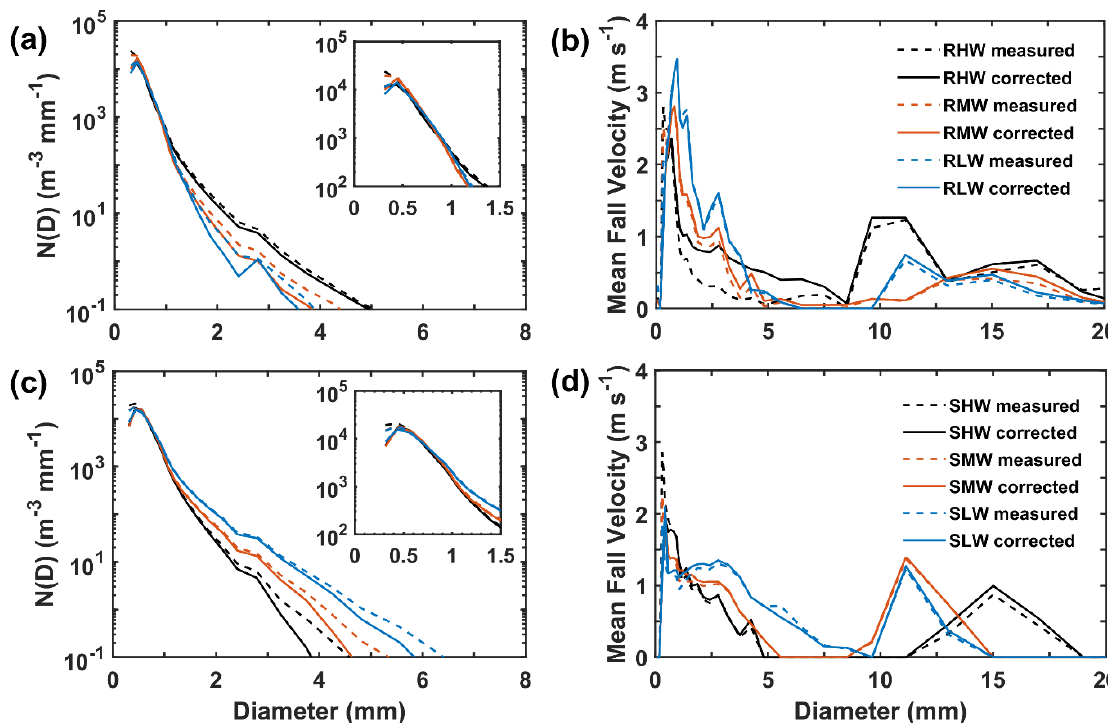
Figure 6. Mean raindrop size spectra for liquid and solid precipitation groups ( a , c ) and mean particle fall speed as a function of particle diameter ( b , d ). The dashed line refers to measured DSD , while the continuous line refers to corrected DSDs . For better visualization, raindrop size spectra values for D ≤ 1.5 mm are zoomed in the inset plot.